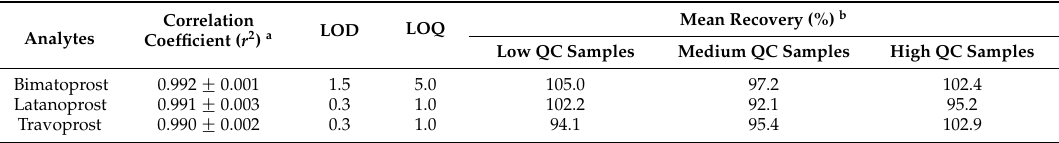
Table 2. Calibration curve parameters, LODs, LOQs and recovery of prostaglandin analogs in eyelash enhancing products.